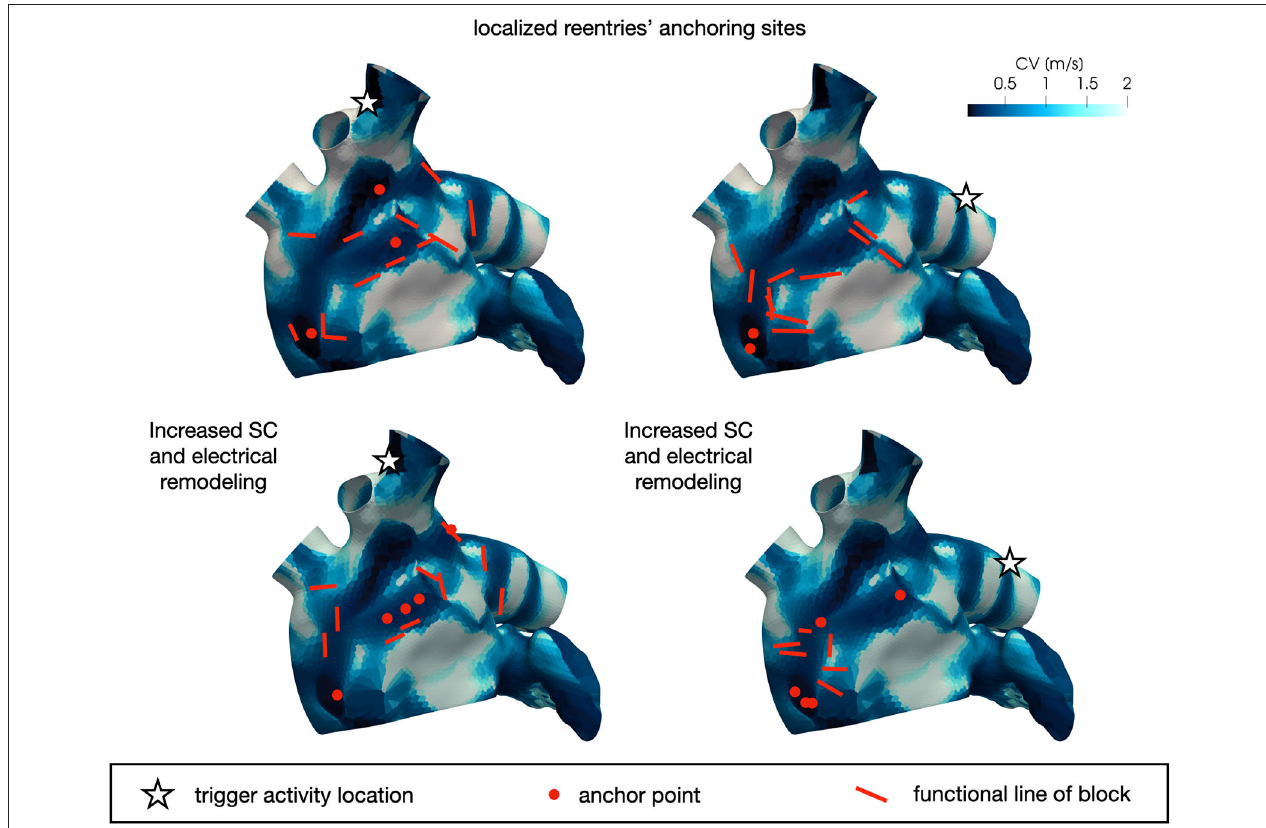
FIGURE 10 | Position of localized reentry anchor points or functional lines of block in the analyzed cases generated from the CV field of the persistent patient. The progression of the disease (bottom) generates more anchor points, which sustain the localized reentries.